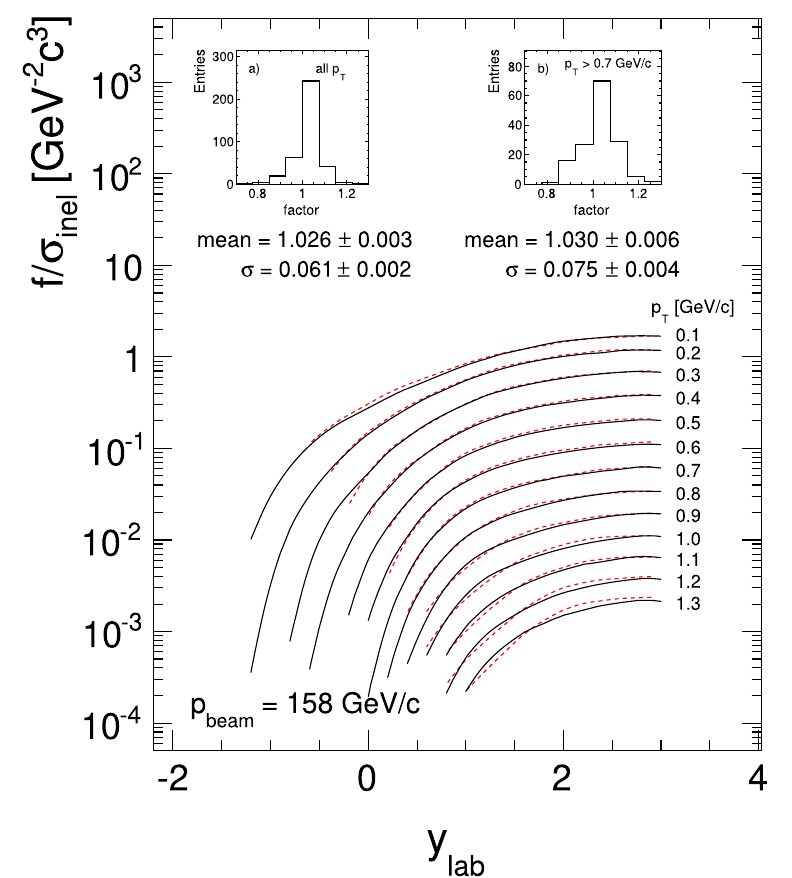
Fig. 62 Interpolated cross sections f /σ inel [35] as functions of p T and y lab at 158 GeV/c beam momentum (broken lines) compared to the global interpolation (full lines) in steps of 0.1 GeV/c in p T . The insets show the distribution of the factors relative to the general interpolation for all p T values and for p T > 0.7 GeV/c